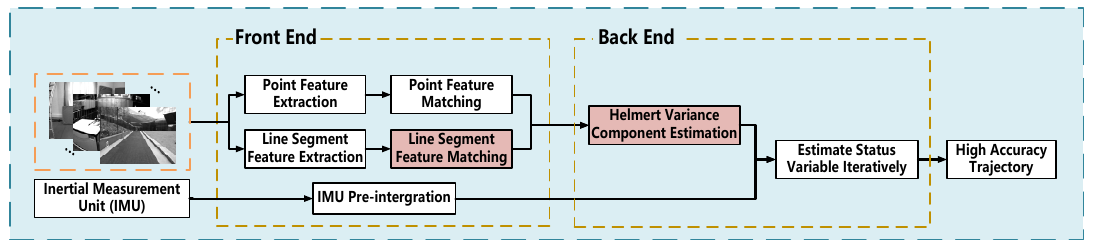
Figure 1. Overview of our improved point–line visual–inertial odometry (IPL–VIO)